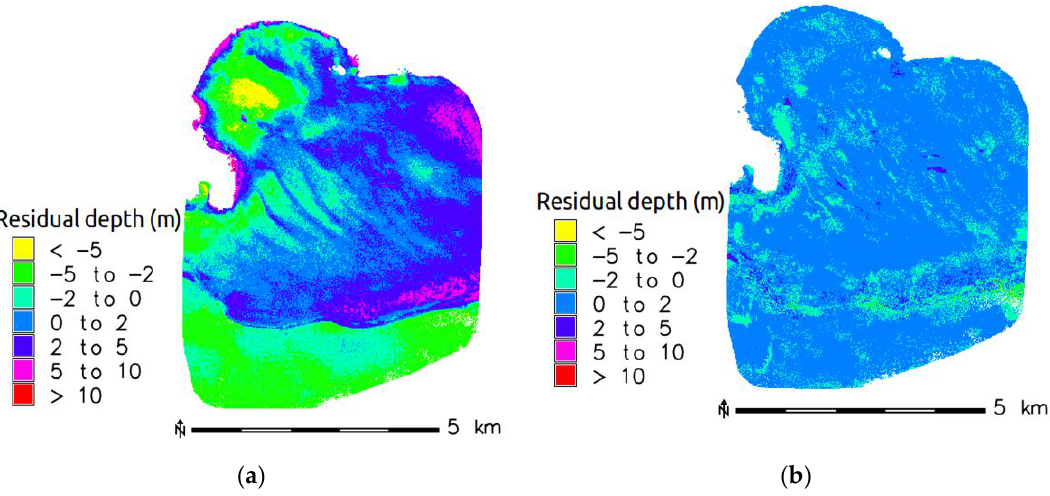
Figure 3. Comparison between residual maps of ( a ) global model and ( b ) Geographically Weighted Regression (GWR) model for case study 1.